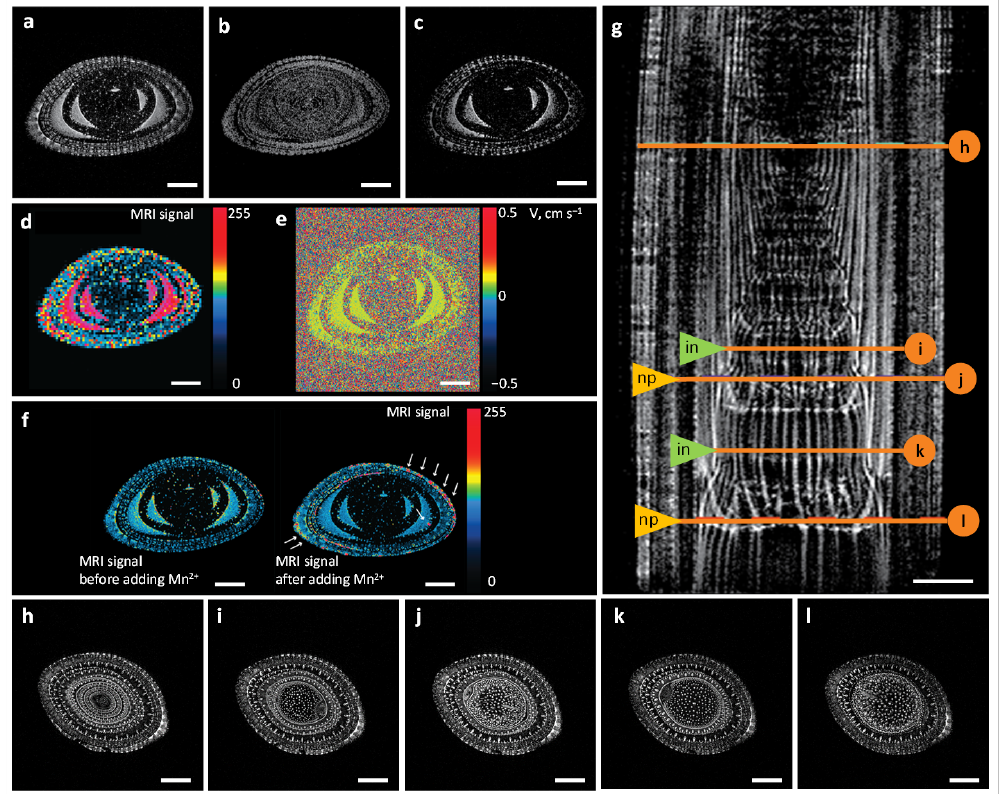
Figure 1. MRI methods for mapping the water distribution in maize stem tissues: T 2 -weighted MRI ( a ); proton-weighted maps of non-aqueous ( b ) and aqueous ( c ) proton distributions; diffusion- weighted MRI ( d ) and velocity map of water flow through a virtual slice ( e ). ( f ) T 1 -weighted MRI before and after root exposure to MnCl 2 solution (10 mM); the arrows indicate the locations of manganese ion accumulation; pseudo-staining reflects the intensity distribution of the MRI signal on the scan; MRI scans are axially oriented. ( g ) T 2 -weighted MRI image of the growth zone of leaves and stem of maize; a longitudinal section of the stem ( g ) and some transverse sections ( h – l ) located in internodes (in, in the figure) (for ( i , k )) and nodal plexuses (np, in the figure) (for ( j , l )) are indicated; the pixel size was 56 × 56 µm, and the slice thickness was 0.5 mm. Turbo Rapid Imaging with Refocused Echoes (TurboRARE)